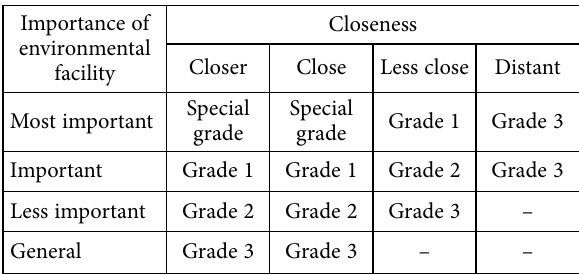
Table 1. Rating of environmental safety risks